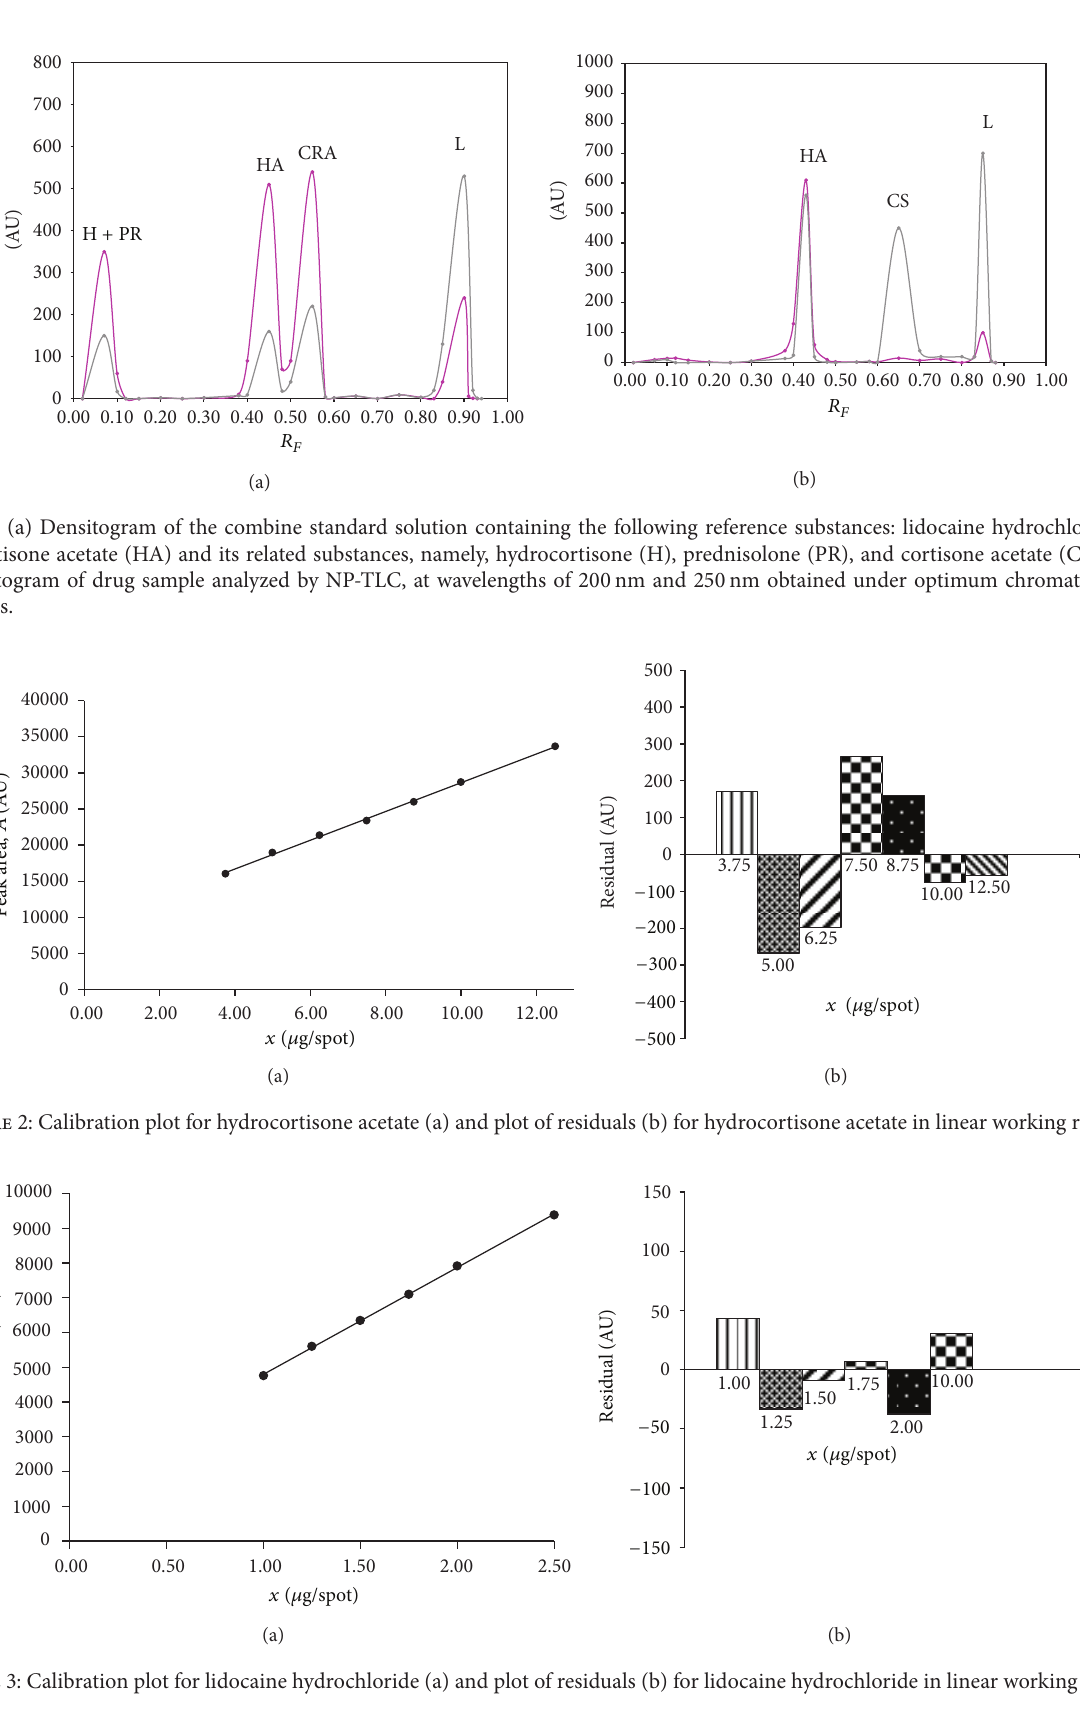
Figure 3: Calibration plot for lidocaine hydrochloride (a) and plot of residuals (b) for lidocaine hydrochloride in linear working